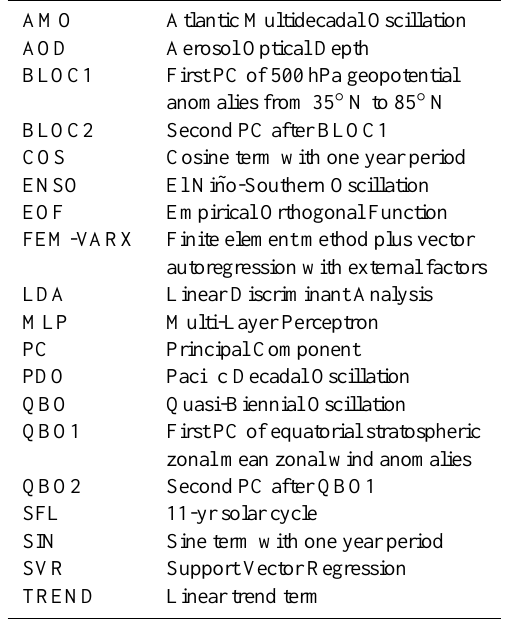
Table 1. The acronyms and their meanings as used in this